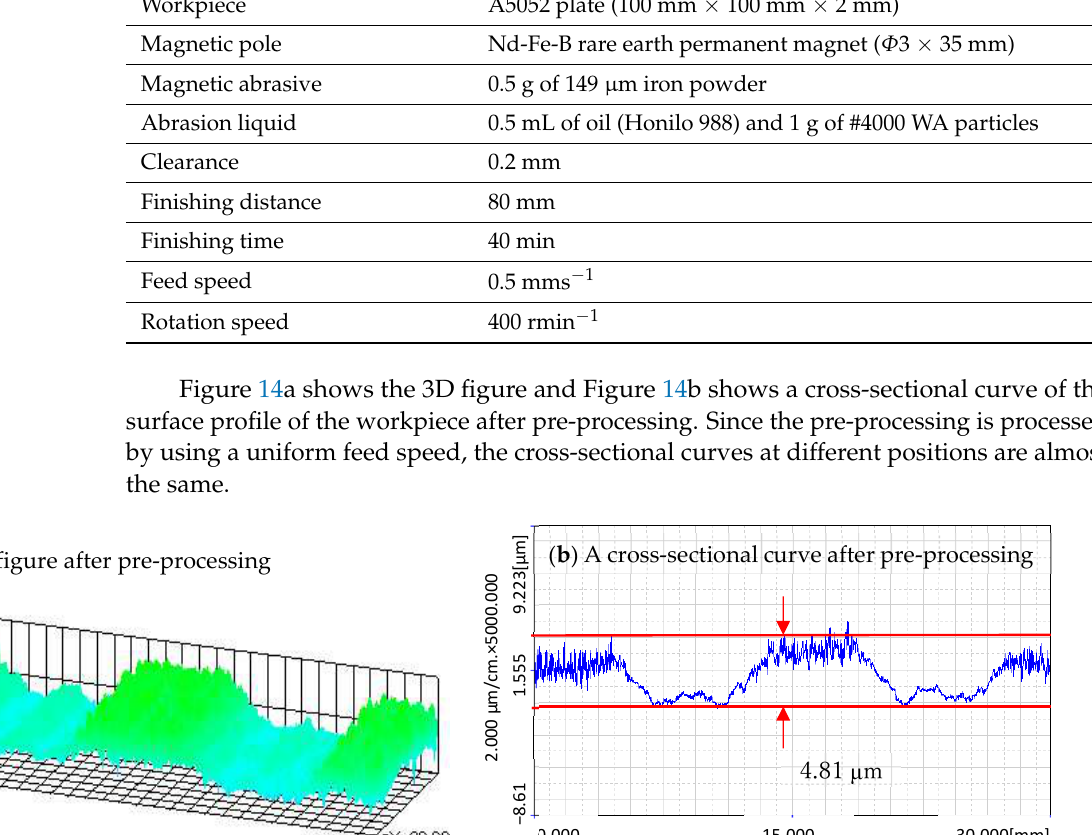
Table 2. Experimental conditions of preparation finishing. Figure 13. The workpiece after pre-processing.